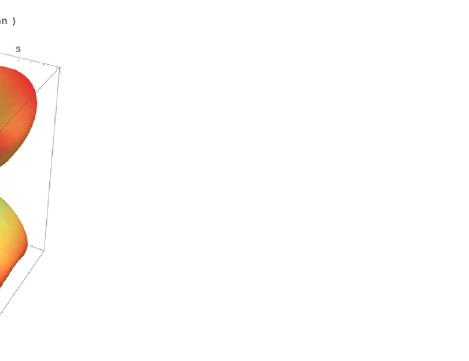
Figure 1. Energy emitted per steradian for an ultra-relativistic electron (with β = 0 . 9) traversing a sheet of mono-layer graphene ( ε F = 0 . 5 eV and τ v = τ F = 4 . 1 of 30 ◦ from the